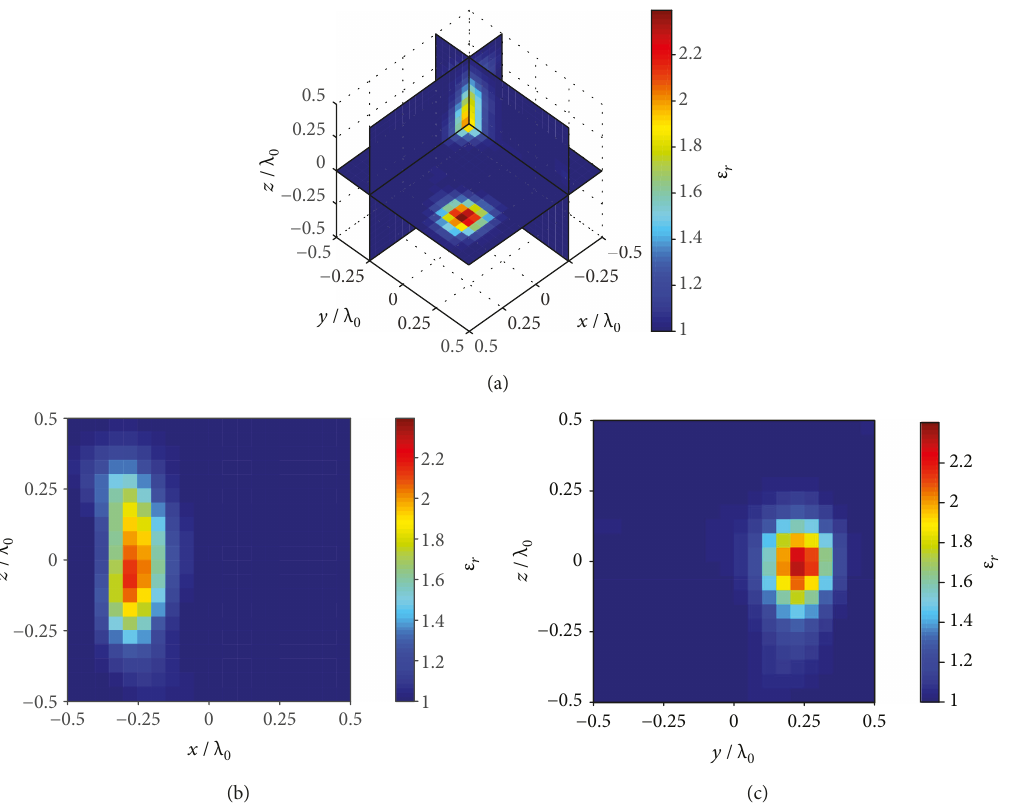
Figure 7: Reconstructed distribution of the dielectric permittivity with p = p ); and (c) yz -plane cut ( x = 0 25 λ ( y = − 0 25 λ 0